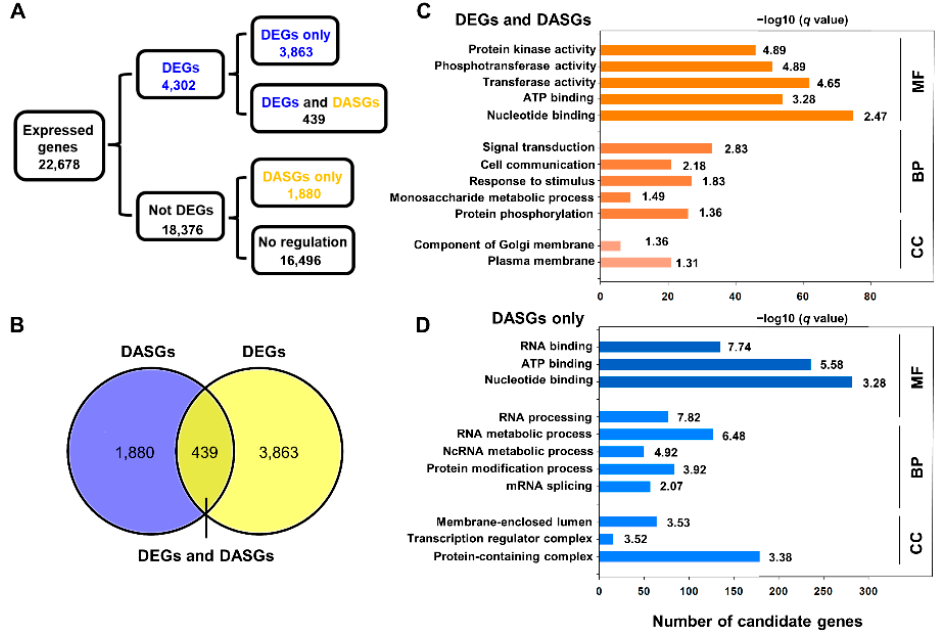
Figure 7. Analysis of differentially expressed (DE) and differential alternative splicing (DAS) genes in cold stress. ( A ) Flow chart showing the statistics analysis of the DE and DAS genes. ( B ) Venn diagrams showing the overlap of genes with DAS events and DE genes. ( C ) GO enrichment of genes with both DE and DAS in response to cold. ( D ) GO enrichment of genes with differential alternative splicing only in response to cold. Bar graph of − log10 transformed q values are shown. MF, molecular function; BP, biological process; CC, cellular